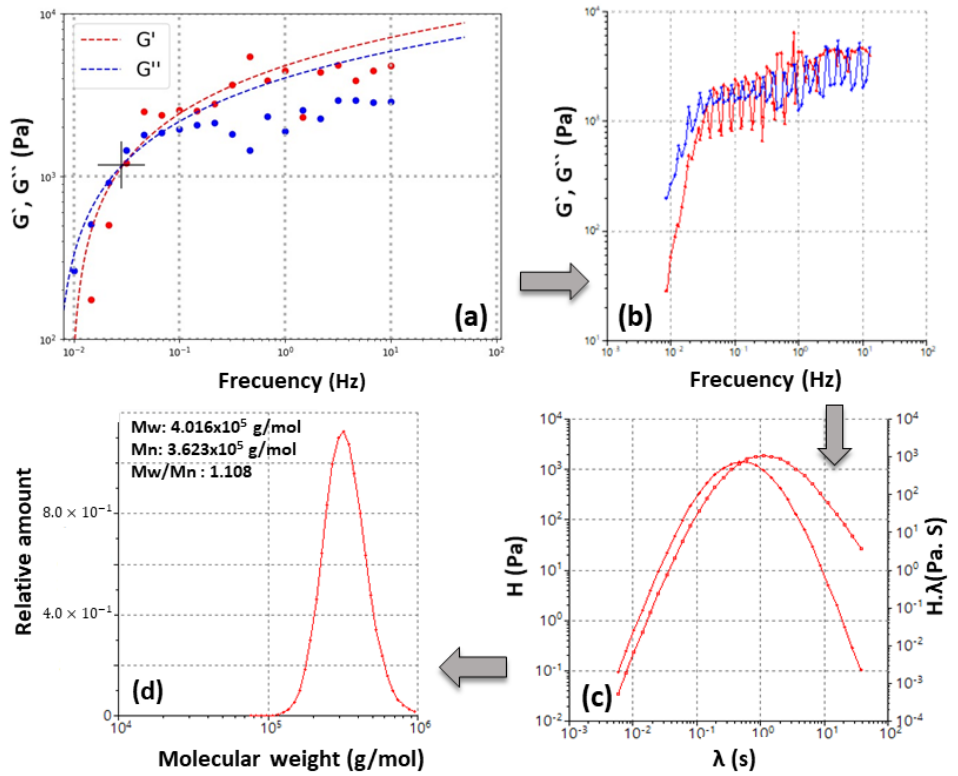
Figure 3. The sequence of steps to apply the proposed method to obtain the MwD by the rheological route: ( a ) fitting applied to the G ′ and G ″ curves; as can be observed, there are inhomogeneities in the experimental data when working near T d; ( b ) obtaining the master curve at temperature defined with the TTS time–temperature superposition principle; ( c ) obtaining the relaxation spectrum; and ( d ) solving the equations and plotting the MwD of the sample.